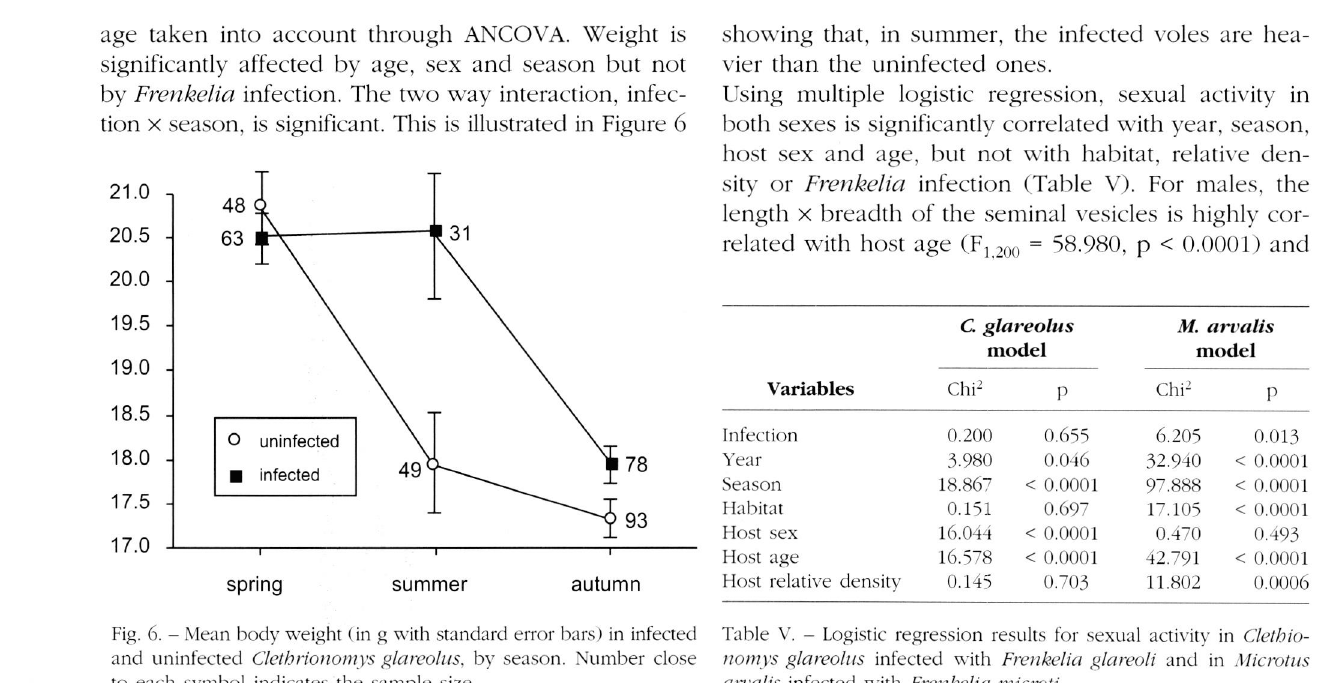
Table V. - Logistic regression results for sexual activity in Clethio- nomys glareolus infected with Frenkelia glareoli and in Microtus arvalis infected with Frenkelia